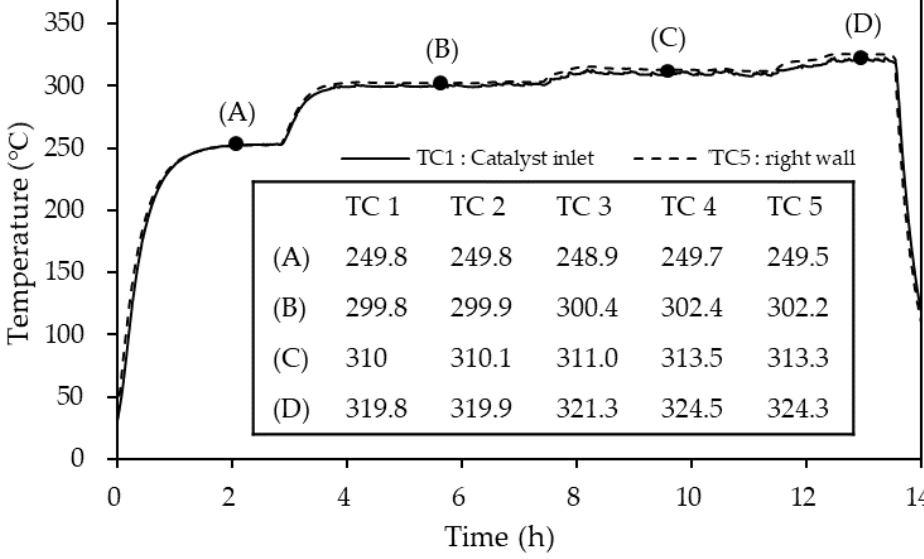
Figure 7. Temperature profile and values of the reactor thermocouples TC 1 – TC 5 at different control temperatures of: (A) 250 °C; (B) 300 °C; (C) 310 °C; and (D) 320